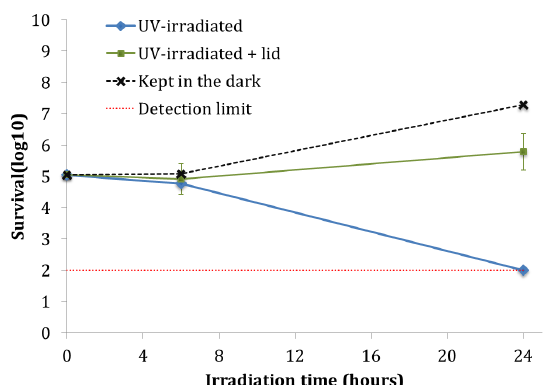
Figure 1. Direct effect of the time of UV irradiation on the survival of Escherichia coli CIP 53126 expressed as the log residual viable bacteria, light intensity ≈ 2.5 W/m 2